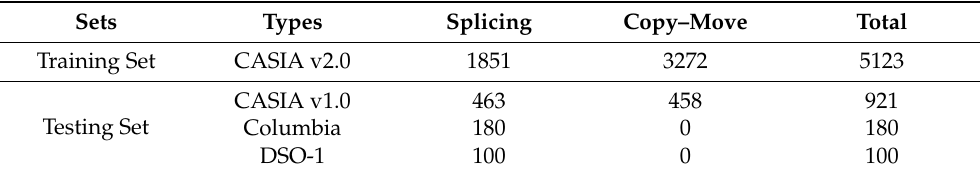
Table 1. Summaries of the